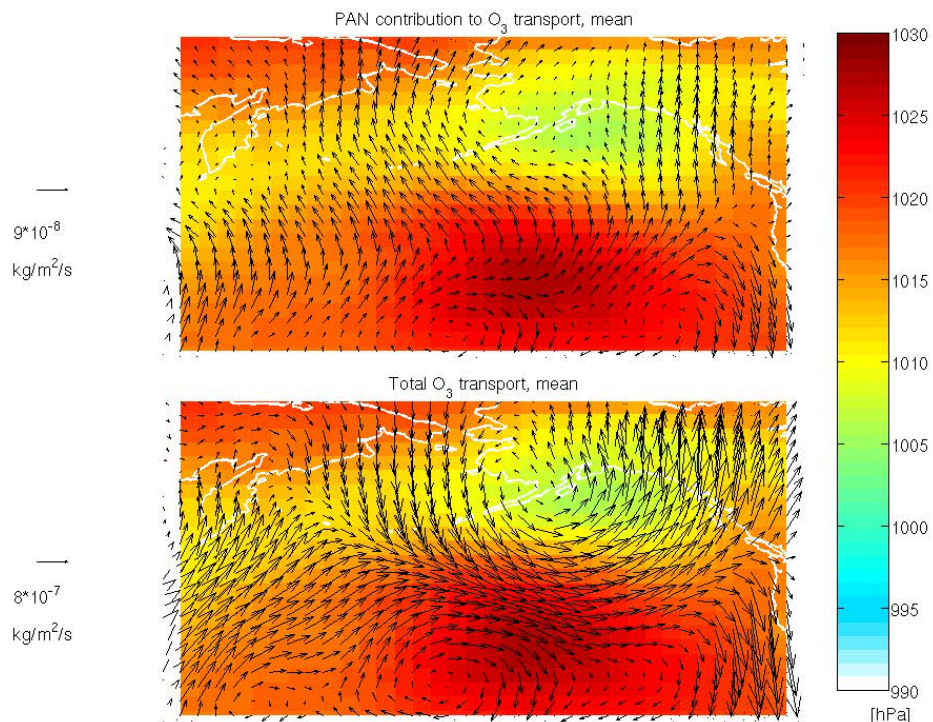
Fig. 12. Simulated ozone fluxes at 2km averaged over the campaign. The two panels overlay mean surface pressure maps over the campaign with average fluxes of total O 3 and that are due to transport of